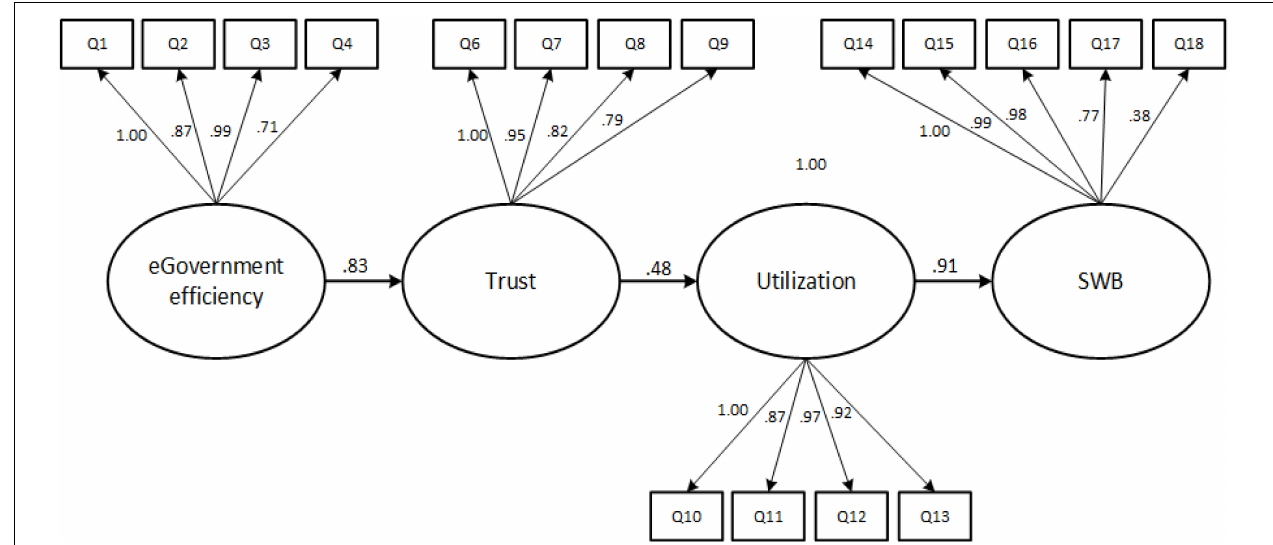
FIGURE 3 | SEM effect of eGovernment efficiency on